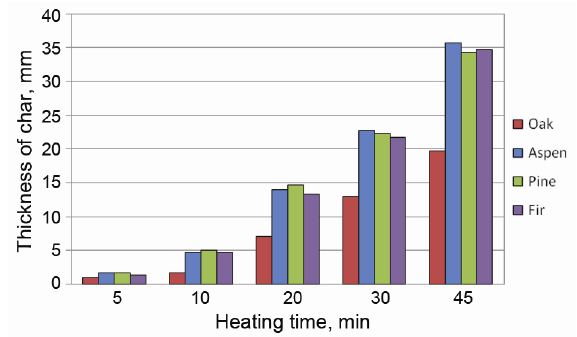
Fig. 10. Average thickness of char forming during heating of wood samples Fig. 10 reflects the thickness of char that forms dur-